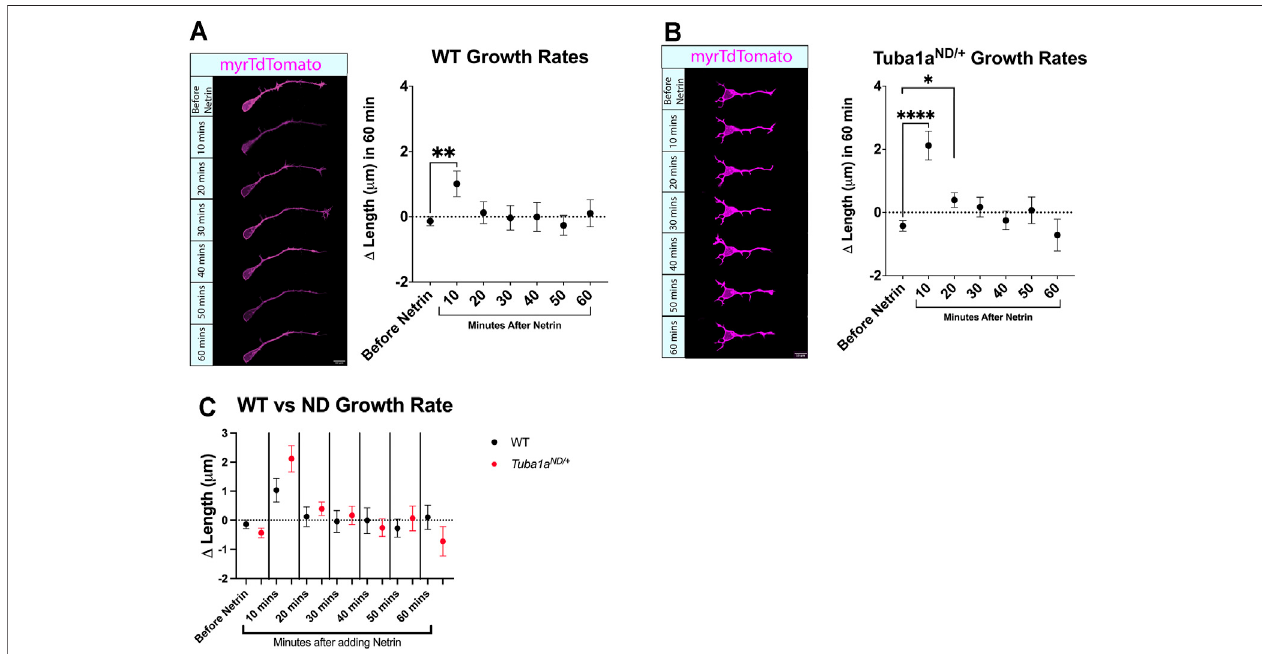
FIGURE 6 | Reduced Tuba1a does not interfere with netrin-1-induced axon growth rates. (A) Primary cortical neuron cell cultures were made from Tuba1a ND/+ mice and wildtype littermates. Cells were plated on glass-bottom dishes and images were collected every 10 min for an hour. Puri fi ed Netrin-1 was then added to the dish at 500 ng/ml and images were taken every 10 min for an additional hour. ( n (cid:1) 77 neurons; p (cid:1) 0.0057, unpaired t -test) (B) . Analysis was repeated for Tuba1a ND/+ mice ( n (cid:1) 91 neurons; p < 0.0001, and n (cid:1) 83 neurons; p (cid:1) 0.0488, unpaired t -test) (C) . To determine if there was a difference in stimulated growth between the wildtype and Tuba1a ND/+ mice the growth values were compared at each time point. No differences were found at any time point.